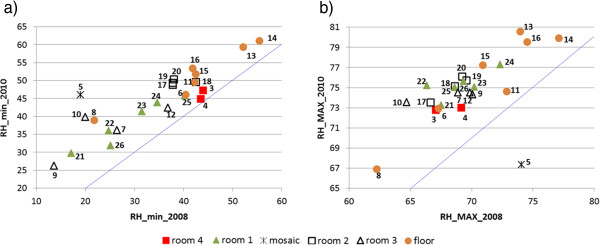
Bivariate plot of daily minimum (RHmin) and maximum (Tmax) relative humidities in 2010 vs. 2008. Bivariate plot of RHmin (a) and RHmax (b) recorded from each probe in 2010 vs. 2008 (14th to 31st of August). The tilted line is the bisector.